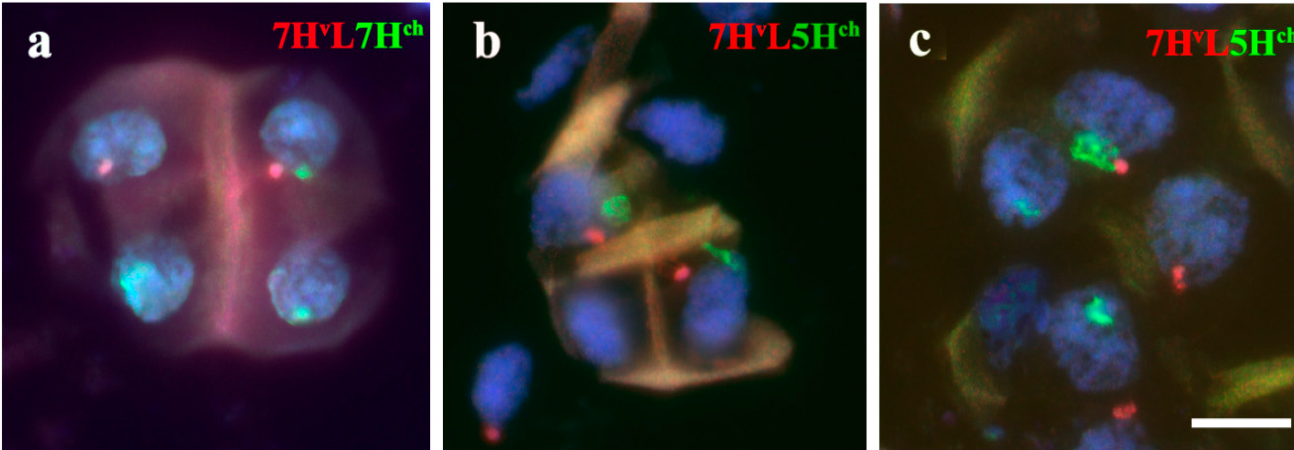
Figure 5. Visualization of barley chromosomes after meiosis in double H. vulgare and H. chilense monosomic addition lines in wheat in the absence of the Ph1 locus. Examples of both H. vulgare (red) and H. chilense (green) chromosomes at the tetrads stage. DNA was counterstained with DAPI (blue). ( a ) Hordeum vulgare and H. chilense chromatin detected in two and three PMCs, respectively, in the double monosomic 7H v L7H ch in wheat in the ph1b mutant background. ( b ) 7H v L5H ch chromosomes detected simultaneously in two PMCs in wheat in the ph1b mutant background. ( c ) Hordeum vulgare and H. chilense chromatin detected in three and three PMCs, respectively, in the double monosomic 7H v L5H ch in wheat in the ph1b mutant background. Bar: 10 µm.